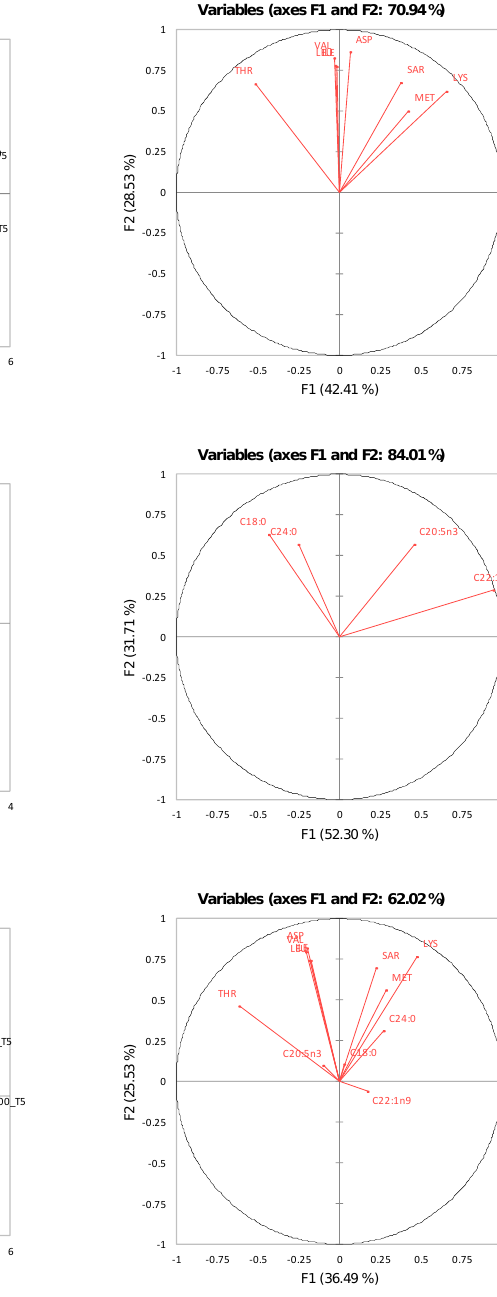
Figure 3. Canonical variate analysis centroids (left) and vectors (right) for: ( a ) free amino acids (F (88,410) = 10.515, p < 0.001), ( b ) fatty acids (F (44,222) = 4.124, p < 0.001), and ( c ) both free amino acids and fatty acids (F (132,233) = 8.666, p < 0.001) of Storm Shell ( Mactra murchisoni ) clam.